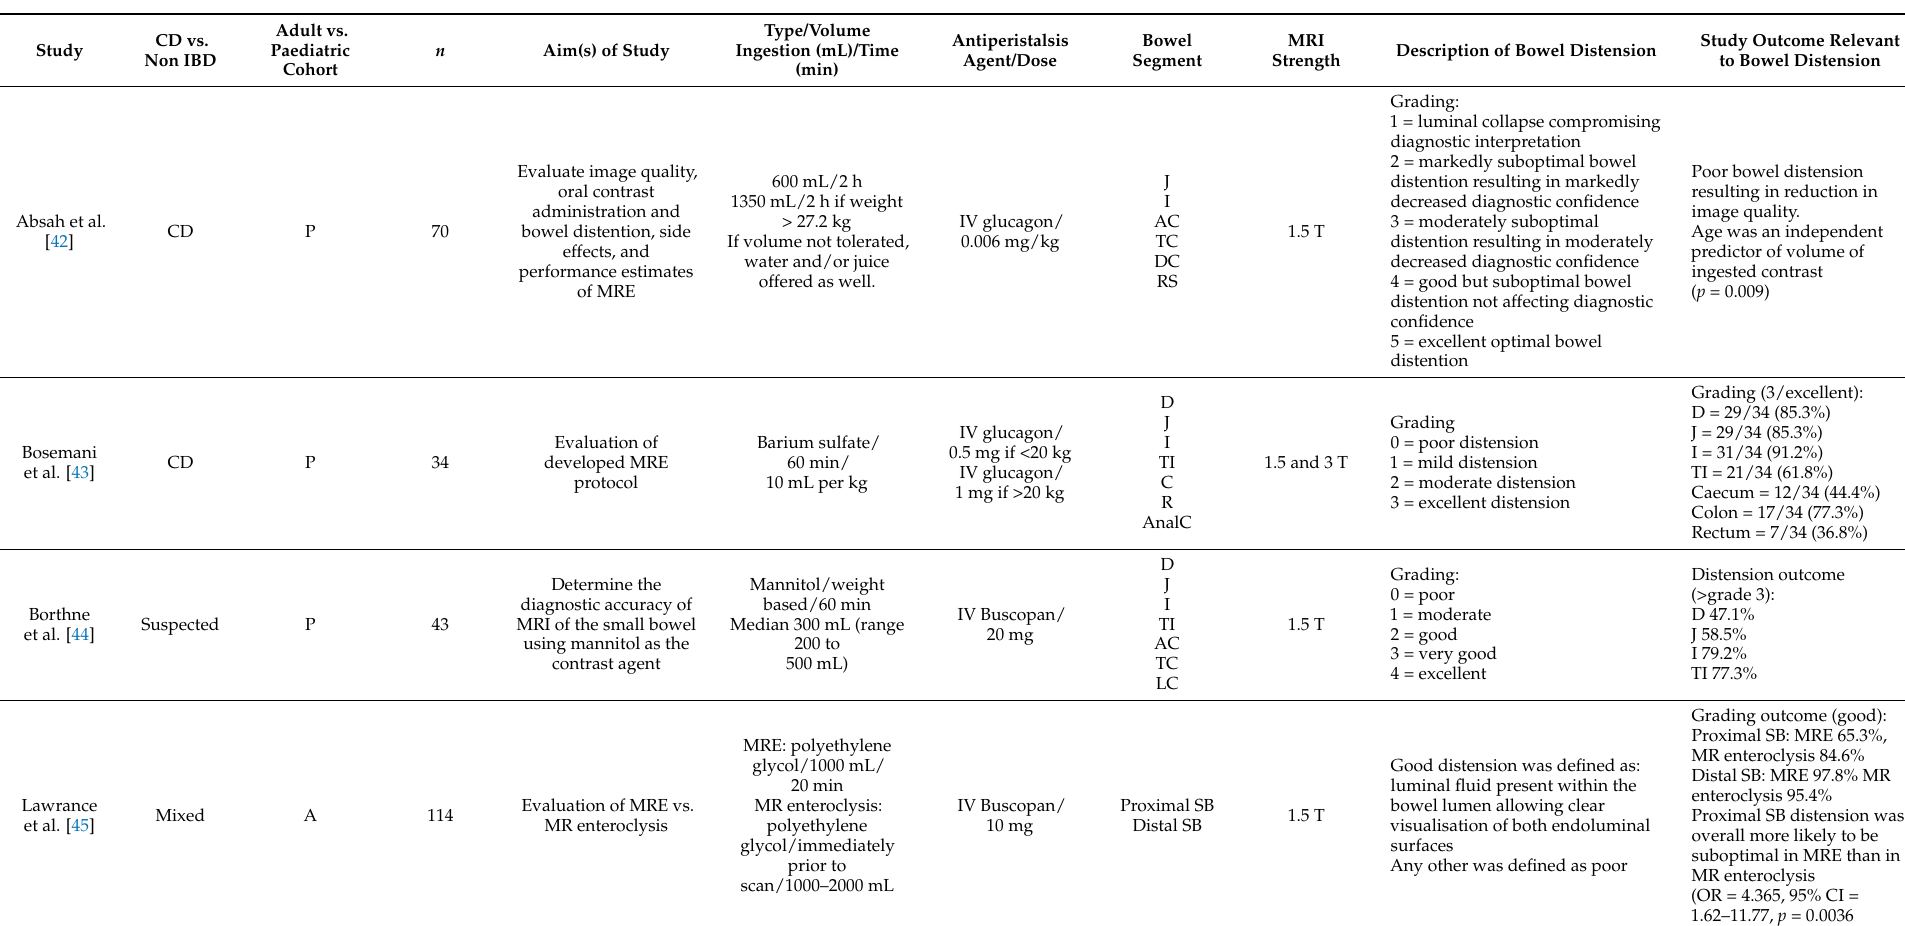
Table 2. Summary of MR enterography studies describing bowel